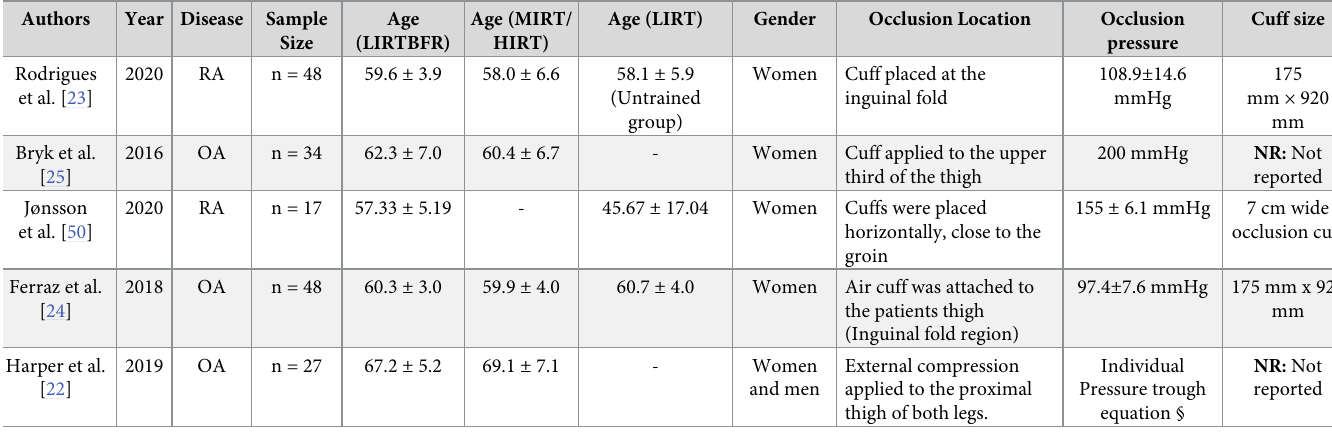
Table 1. Characteristic of the included